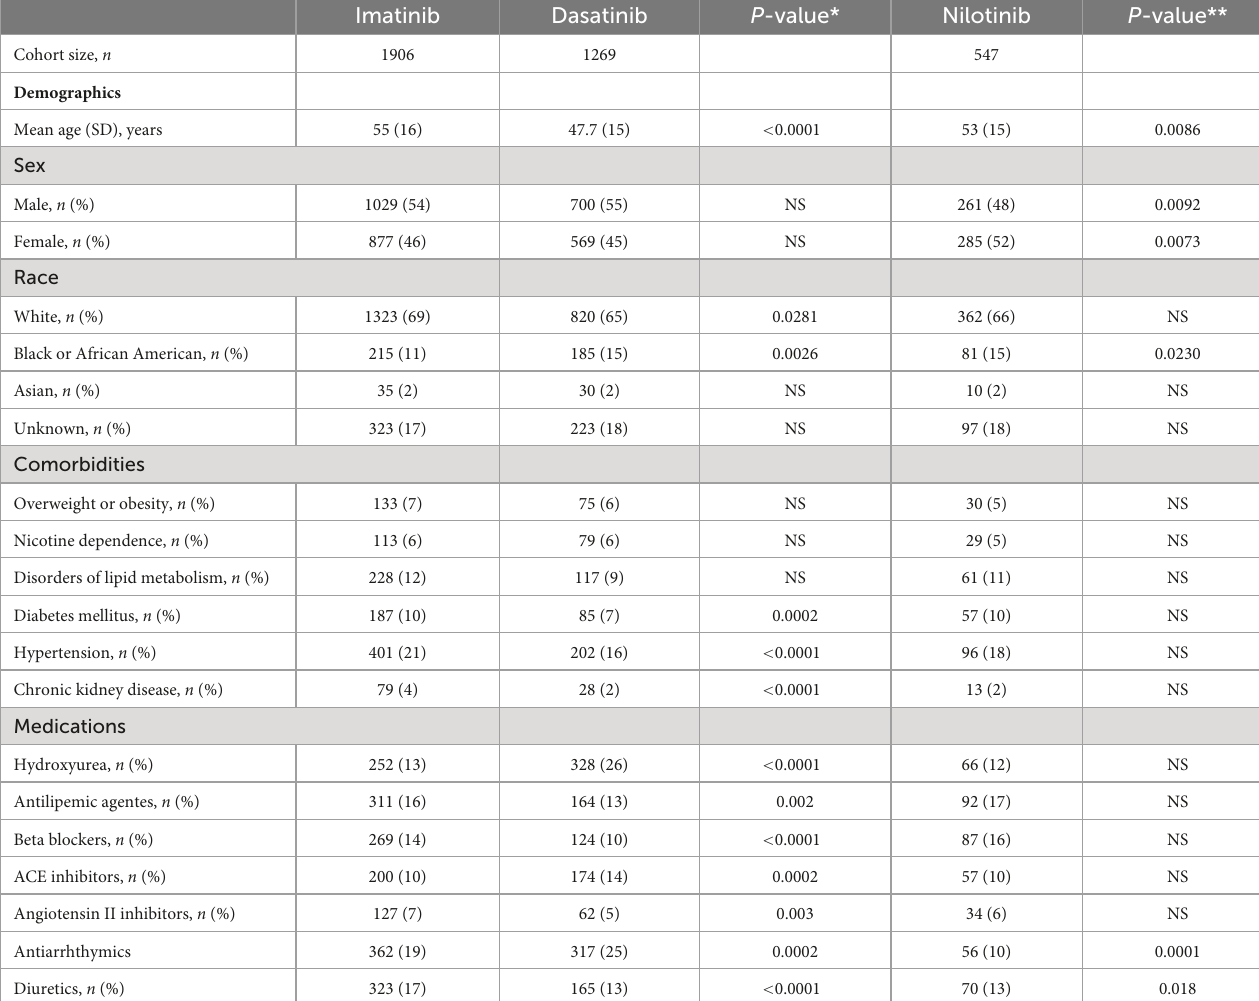
TABLE 1 Baseline characteristics of the cohort for the imatinib, dasatinib, and nilotinib groups. Imatinib Dasatinib P